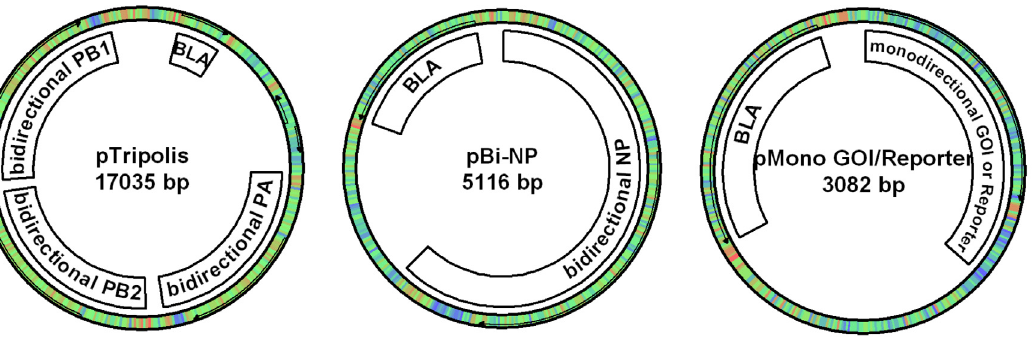
Figure 1. Schematic drawings of plasmids used to generate the influenza replicon based expression system. pTripolis and pBi-NP generate the influenza replicon (mRNA/protein and vRNA) whereas pMono plasmids with various genes of interest or reporter genes drive transcription of vRNA.